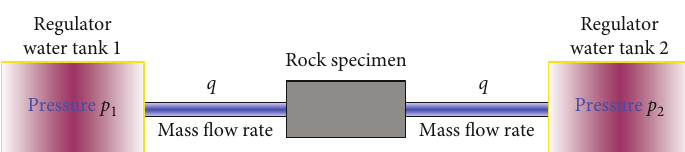
Figure 3: MTS816 rock mechanics permeability experimental system.